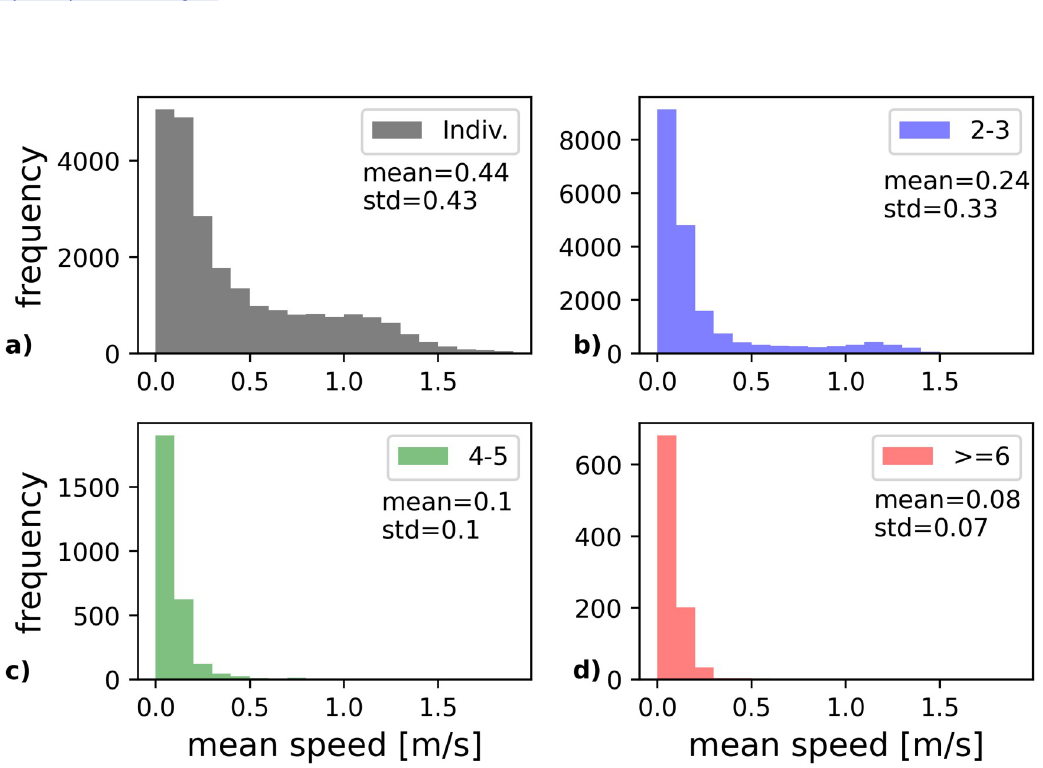
Fig 5. Mean speed of passengers during afternoon peak hours. (a) Individuals (boarding only) (b) Members of pairs and trios c) Groups with 4-5 members (d) Groups with 6 or more members. With increasing group size, the mean speed decreases.